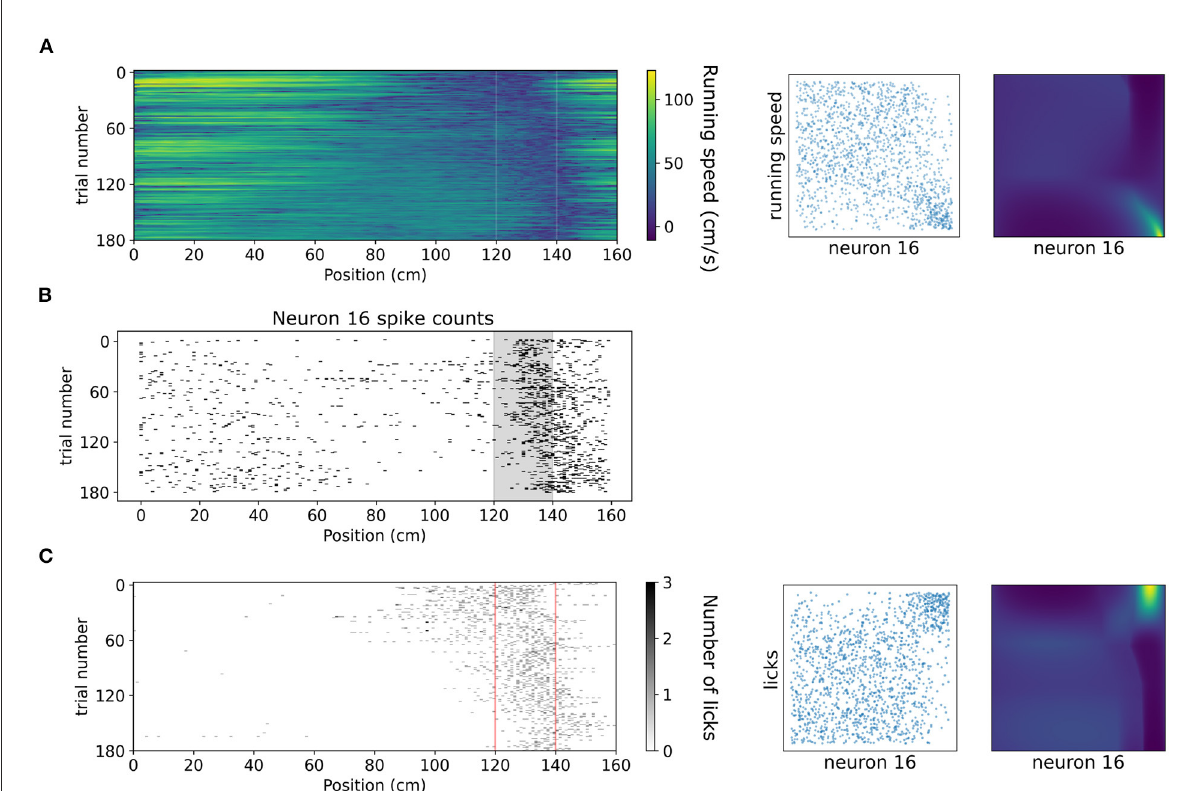
FIGURE8 Dependencies of spiking activity with behavioral variables. (A) Left: Color plot of running speed (cm/s) across the virtual corridor for all trials. White vertical lines denote beginning and end of reward zone. Center: Empirical copula of neuron 16 spiking activity (discrete) with running speed (continuous). Right: Copula density from the trained NSF. (B) Raster plot of neuron 16 spiking activity across trials and position in the virtual corridor. (C) Left: Grayscale-coded plot of number of licks across the virtual corridor for all trials. Red vertical lines denote beginning and end of reward zone. Center: Empirical copula of neuron 16 spiking activity (discrete) with number of licks (discrete). Right: Copula density from the trained